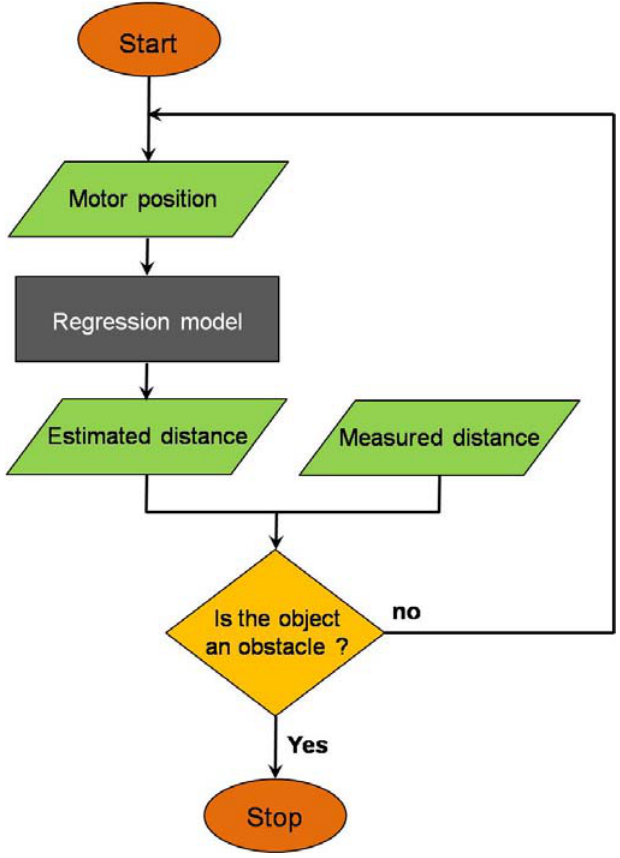
Figure 3. Intelligent decision step: The algorithm determines whether to stop or not by comparing a distance value estimated by the regression model to a distance value measured by the sensor.